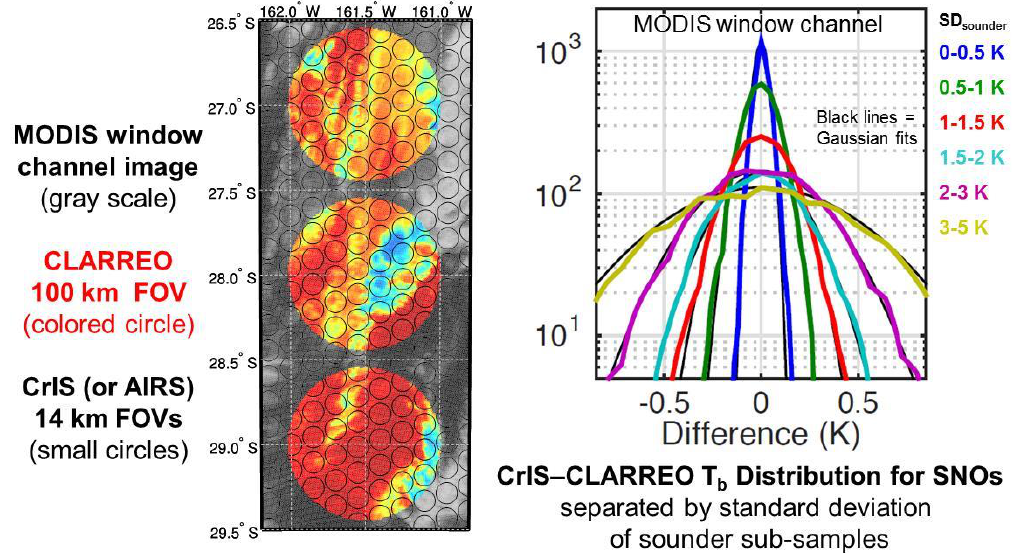
Figure 27. Illustration of the properties of the CLARREO intercalibration approach for comparison to operational sounding instruments. On the left, a black-and-white MODIS image is shown with the large CLARREO footprints color enhanced to illustrate individual Simultaneous Nadir Overpasses (SNOs). MODIS Band 32 brightness temperatures are shown with an RGB color scale with values ranging from 300 K (red) to 200 K (blue). The much smaller sounder footprints are overlaid as black circles. On the right, the key statistical properties of SNOs are shown, demonstrating that the distribution of radiance di ff erences is composed of a summation of Gaussian distributions, each well characterized by the standard deviation of sounder sub-samples in the SNO.